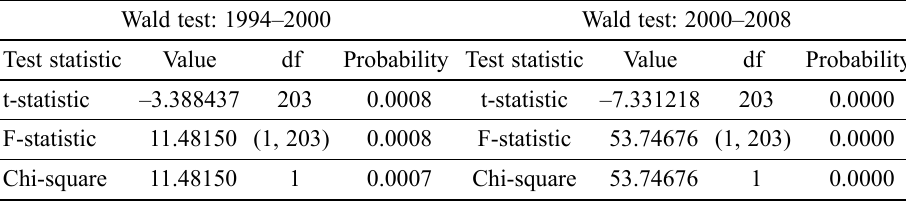
Table 5. Tests of constant returns to scale of the EU-14